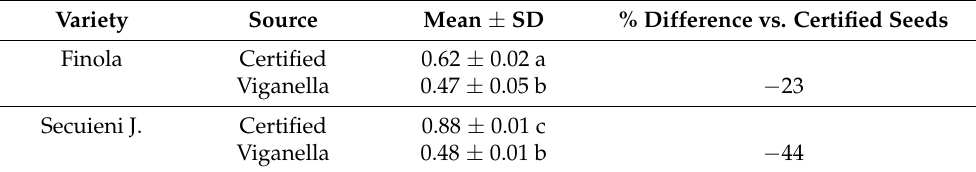
Table 1. Mean weight (g) and standard deviation (SD) of 50 seeds from Finola and Secuieni J. varieties, obtained from the experimental field of Viganella, and certified seeds included as a reference. The decrease in weight of harvested seeds compared to certified seeds is shown as a percentage